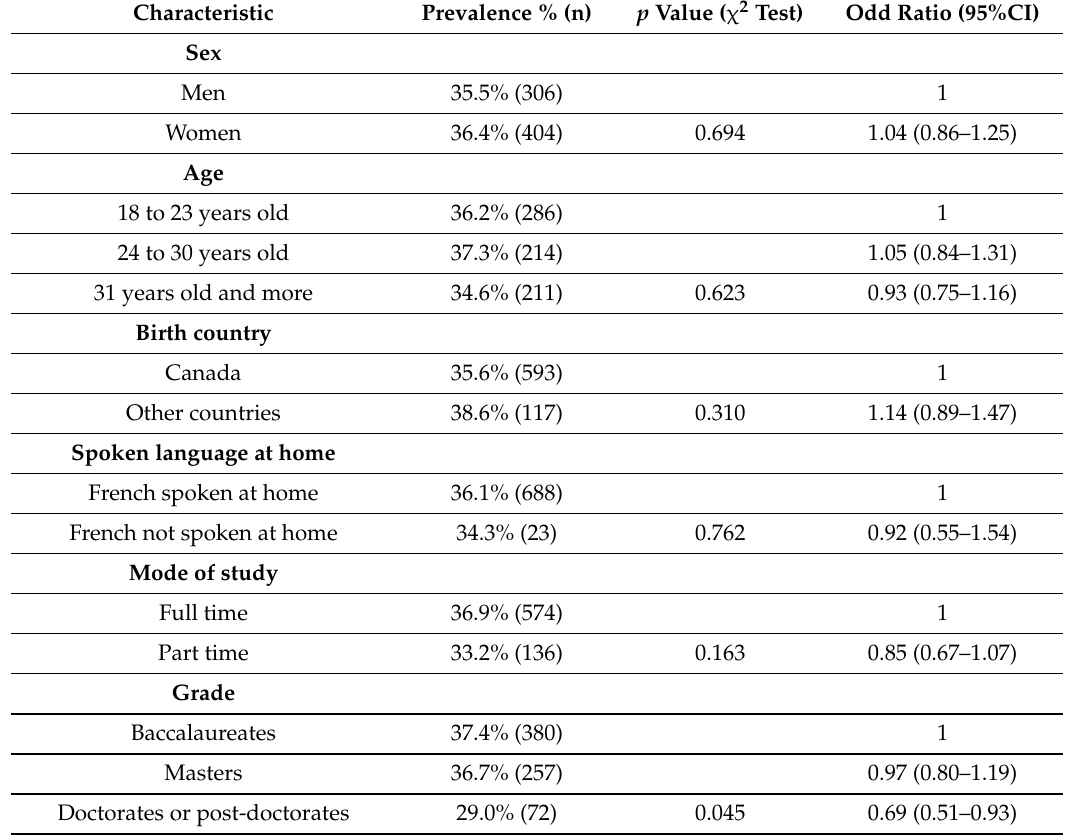
Table 2. Prevalence of residential dampness or mold in student housing by socio-demographic characteristics, Université de Sherbrooke students (QC, Canada), winter